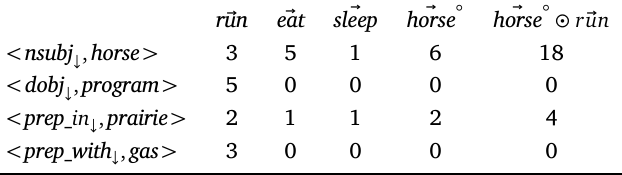
Deriving the vector of red in red car by dependency-based compositionality (dependent function)